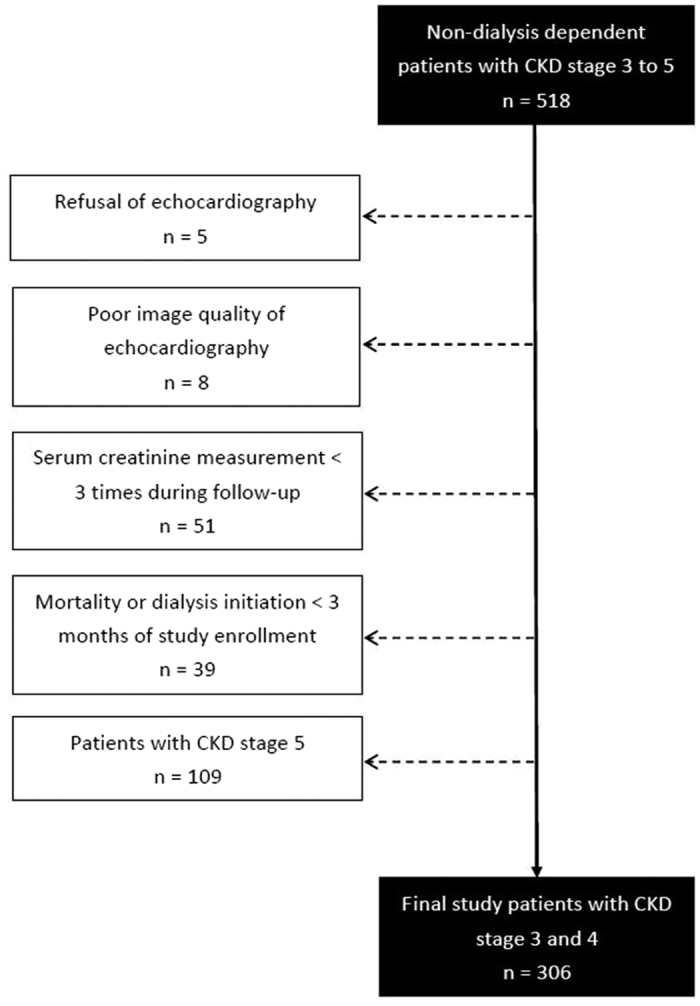
Flowchart of participants analyzed in this study.